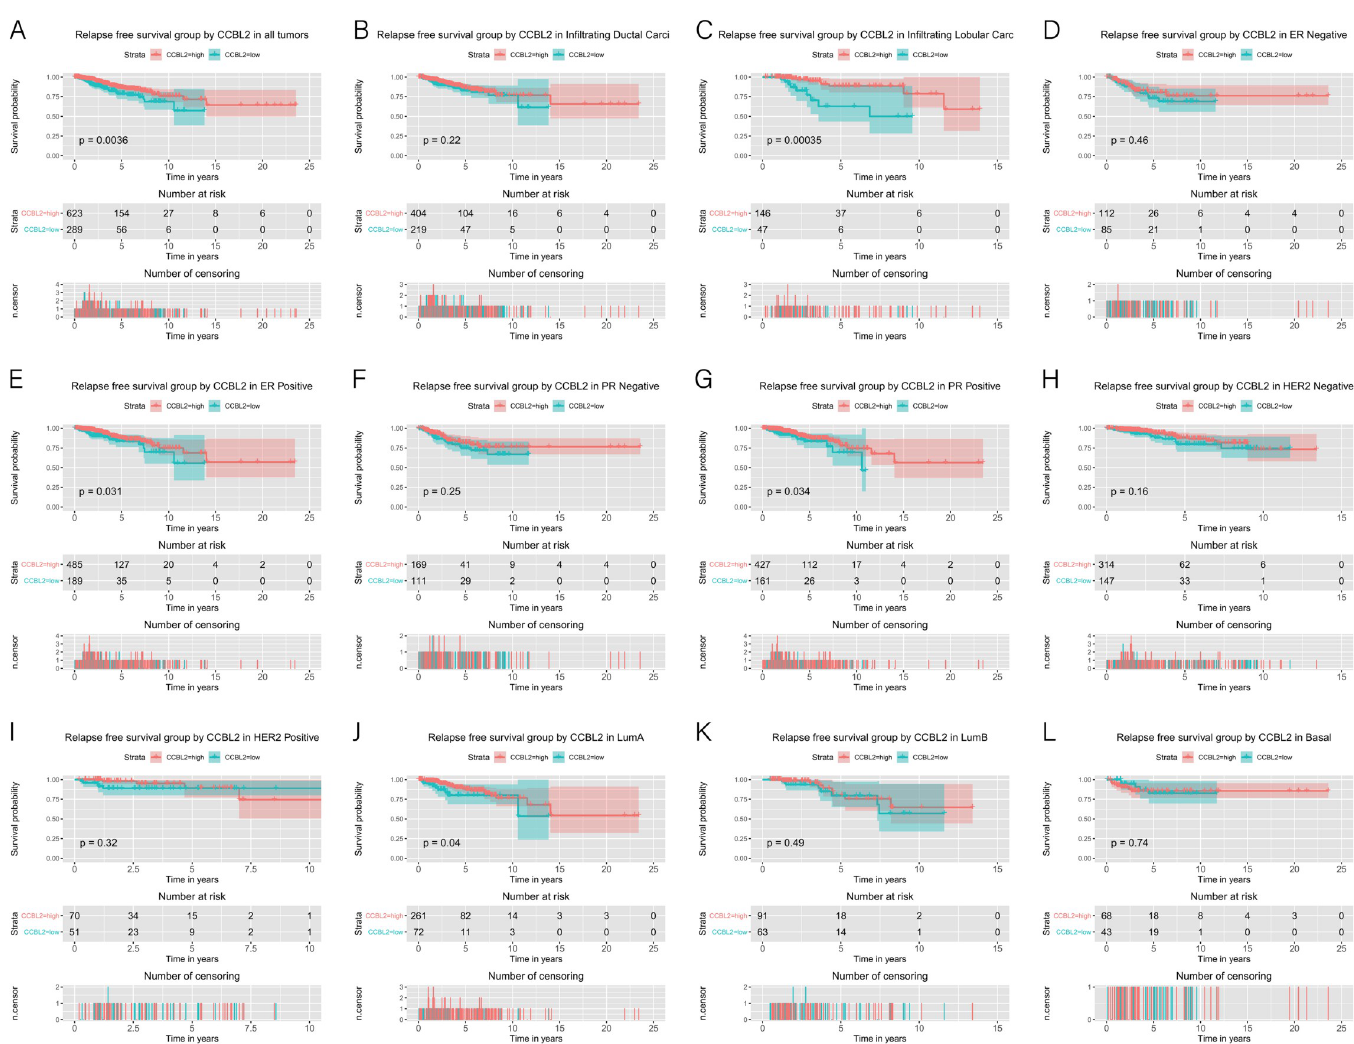
Fig 6. Kaplan–Meier curves of relapse free survival in breast cancer according to CCBL2 expression in breast cancer tissues. Relapse free survival analysis and subgroup analyses of histological type (B and C), ER (D and E), PR (F and G), HER-2 (H and I) and molecular subtype (J, K and L). High CCBL2 expression had relations with the high relapse free survival (p = 0.0036)